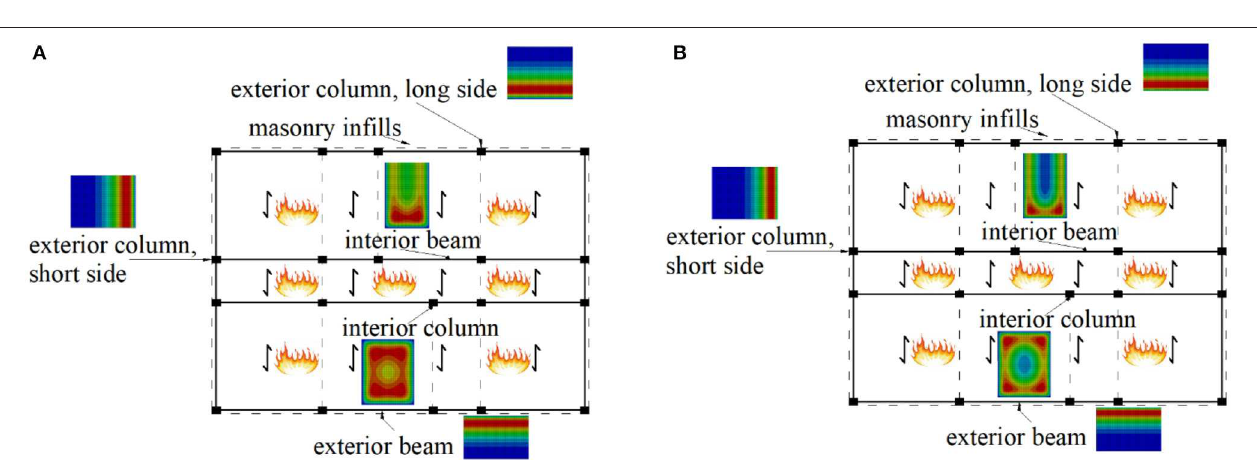
weight of the roof at the third level; live loads of 3.0 kN/m 2 on the first two floors and 0.5 kN/m 2 on the top floor, omitting the snow